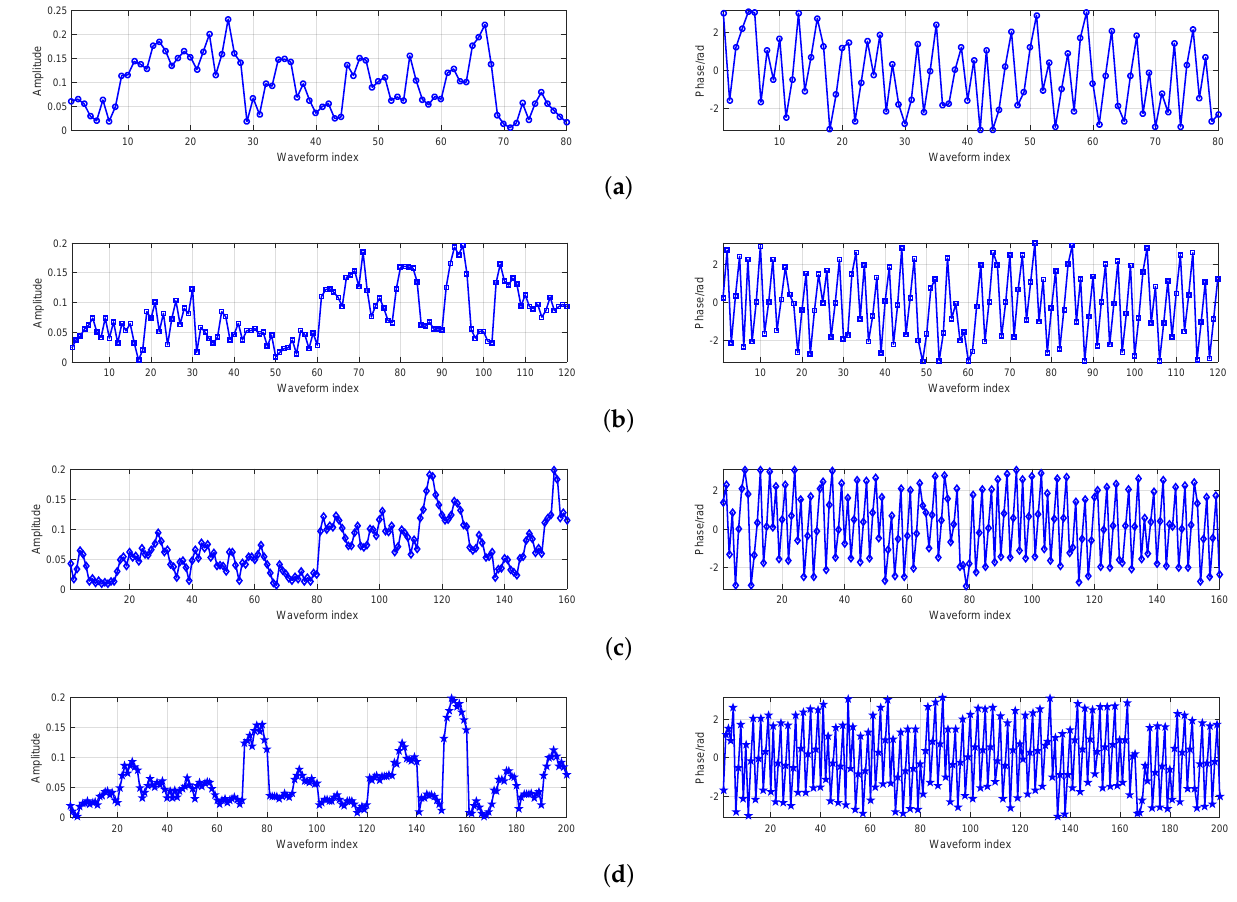
Figure 3. Modulus and phase of the optimized waveform with different transmitting array sizes. ( a ) N T = 4, ( b ) N T = 6, ( c ) N T = 8, and ( d ) N T =